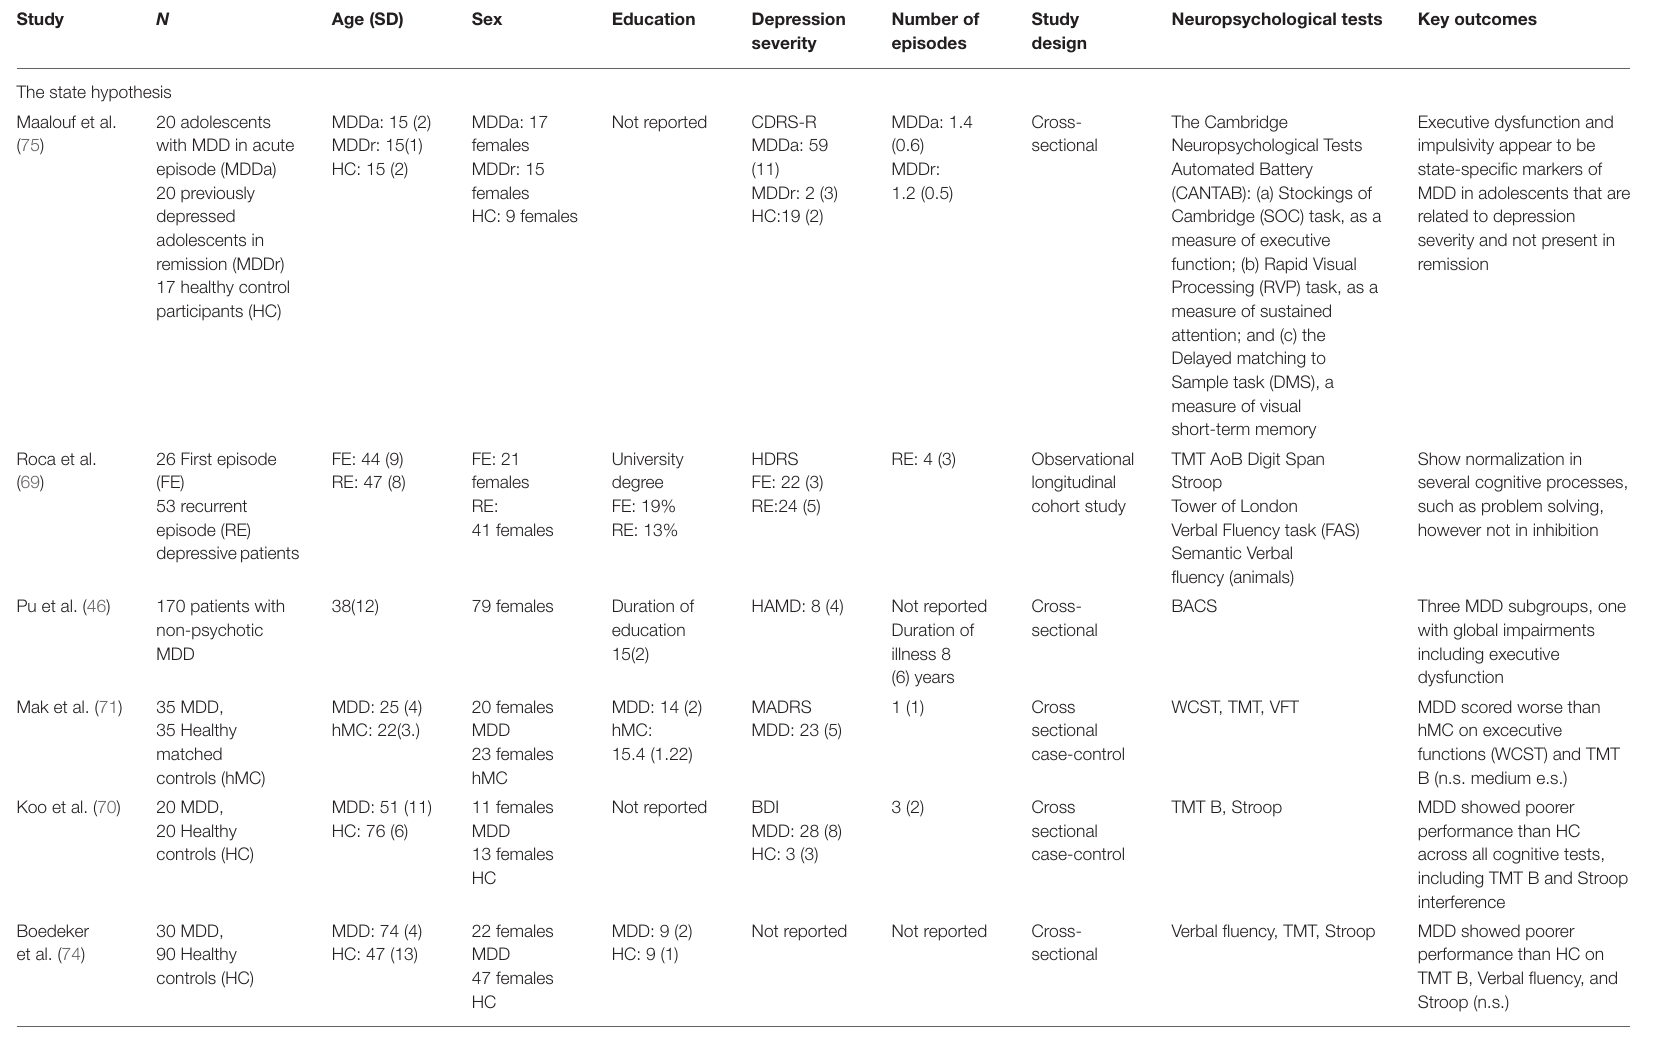
TABLE 2 | Findings within the domain of executive functions regarding origin of